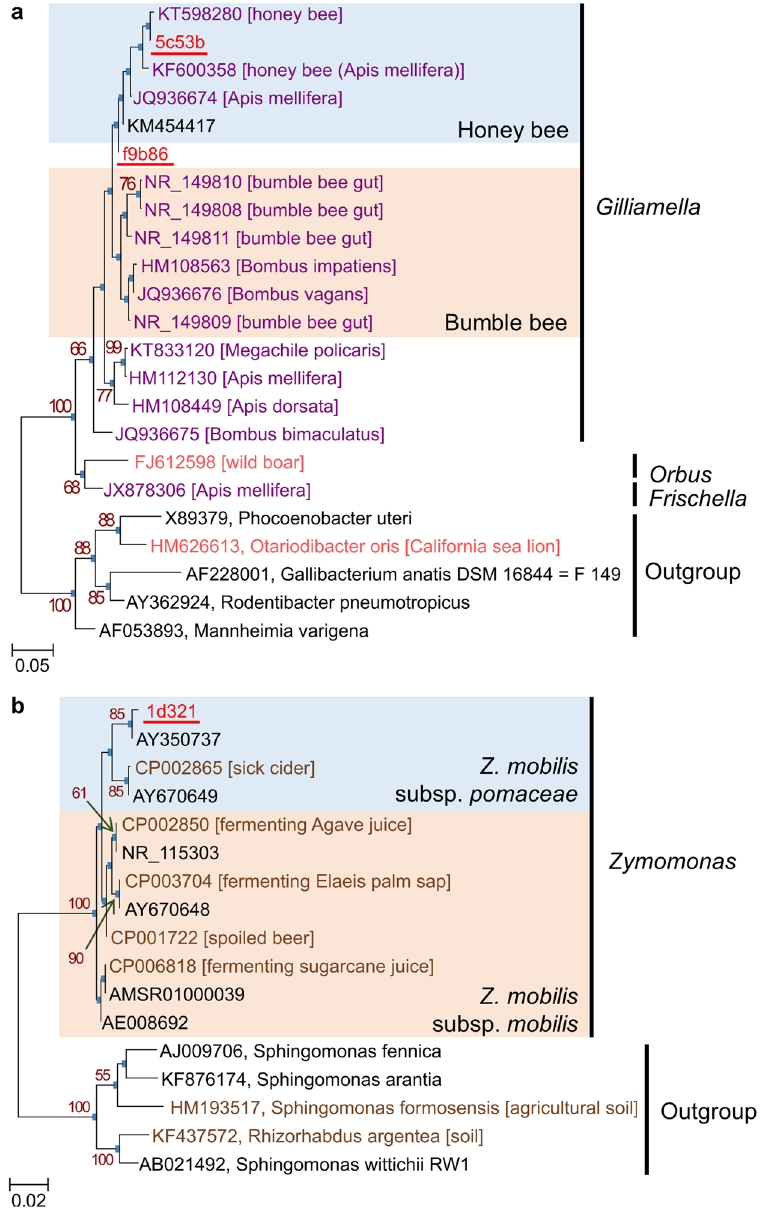
Figure 6. Phylogenetic analysis of Gilliamella - and Zymomonas -related core OTUs in hornet guts. Maximum- likelihood trees of ( a ) Gilliamella and ( b ) Zymomonas . Phylogenetic analyses were performed with maximum- likelihood method. Bootstrap values > 50% are shown. OTUs detected in hornets are red and underlined. Isolation site or host animals, for which Genbank database in NCBI was referred, are indicated in brackets. Scale bar indicates substitutions per position. Accession numbers are colored depending on isolation sites as follows: vermilion, mammal; purple, insect; brown, others; black, not